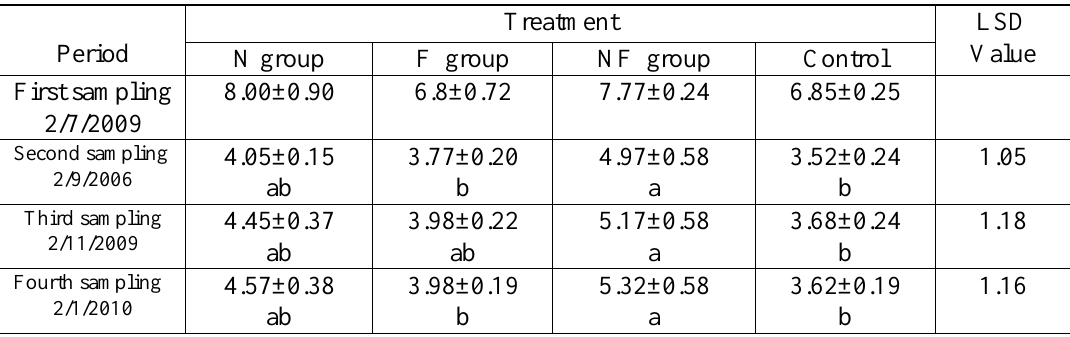
Table (4) Effect of Nigella sativa and / or Fenugreek seeds in the diet on wool staple length (cm) of Awassi male lambs (means ± SE)